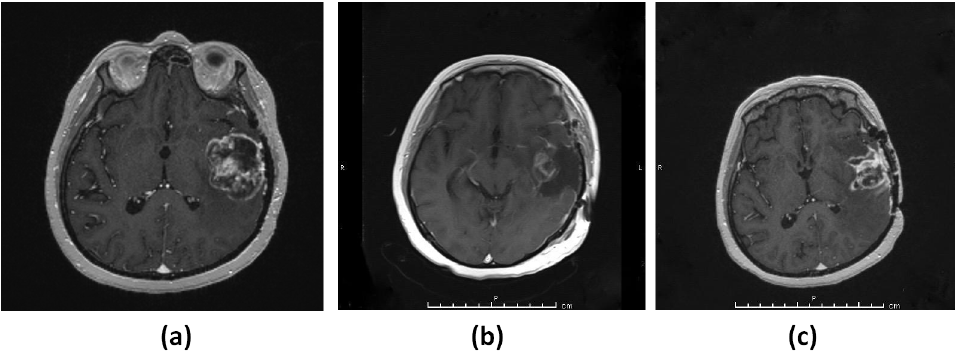
Figure 4. Patient 4 (G5). ( a ) T 1 -weighted MRI showing a contrast-enhancing lesion in the left temporal lobe. ( b ) MRI showing gross total resection of the tumor. ( c ) MRI showing rapid recurrence of the tumor.